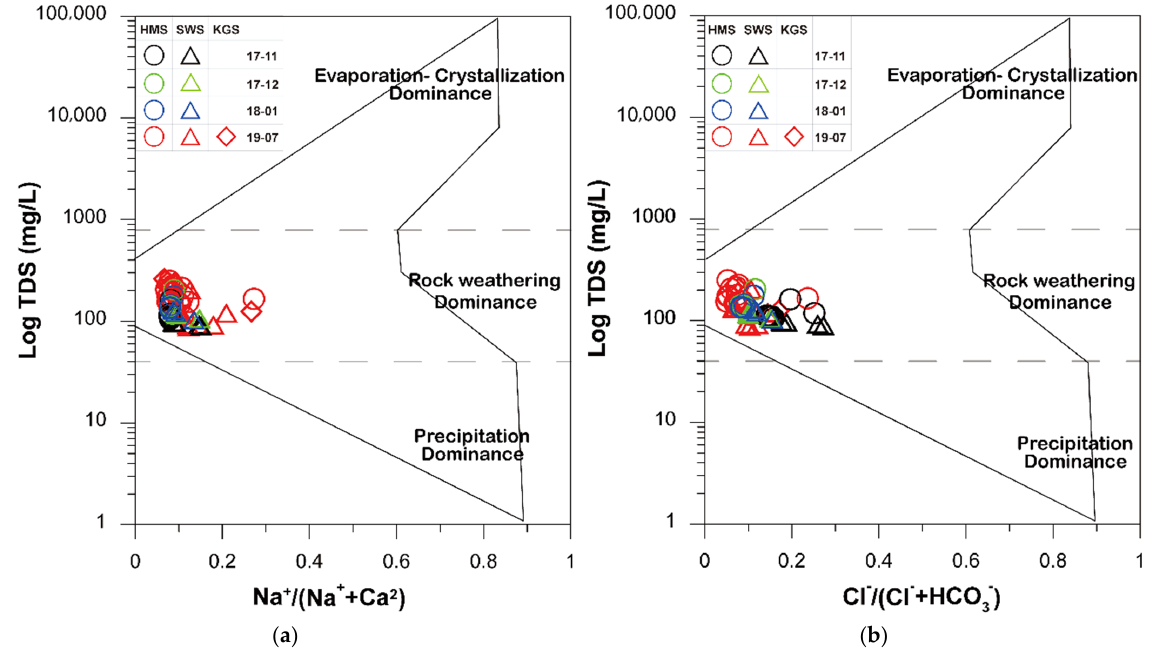
Figure 4. Gibbs diagram of surface water samples in Samcheok: ( a ) relationship between total dissolved solids and Na + /(Ca 2+ + Na + ), and ( b ) relationship between total dissolved solids and Cl − /(Cl − + HCO 3 −